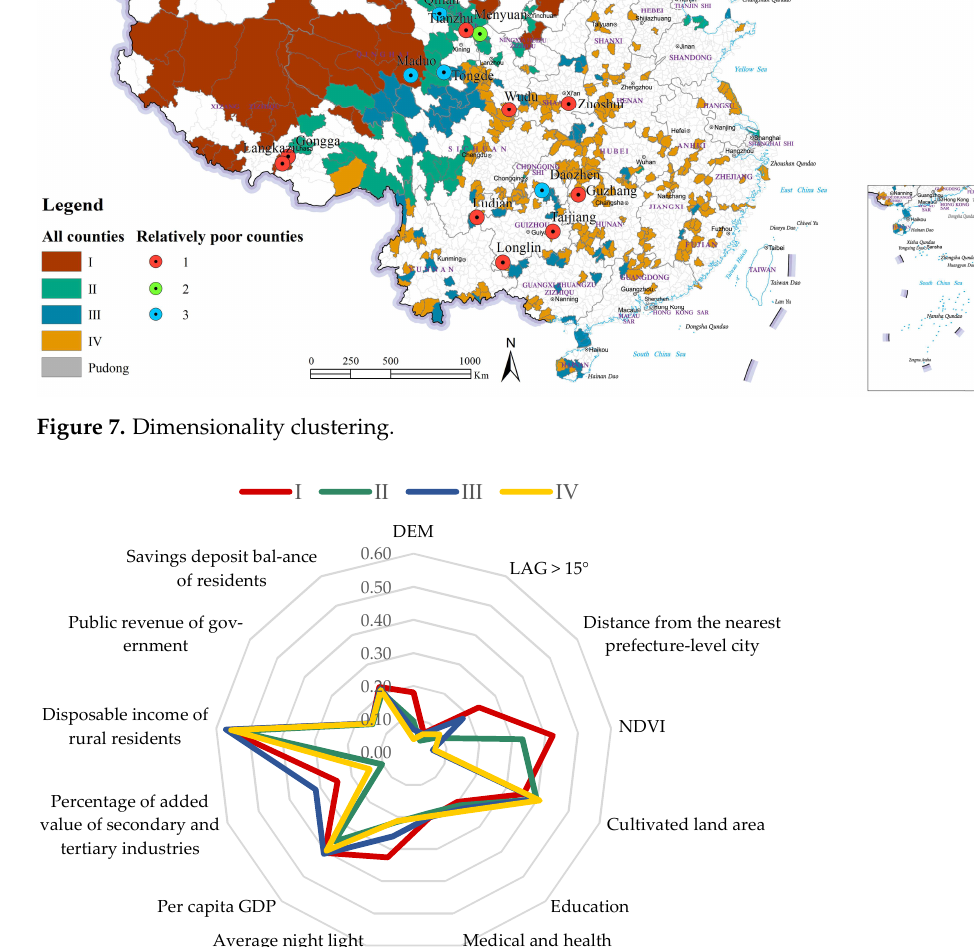
economies. These counties are mainly located in the suburbs of large cities. Within the 89 counties, 30 were relatively substandard counties were 32 are relatively poor